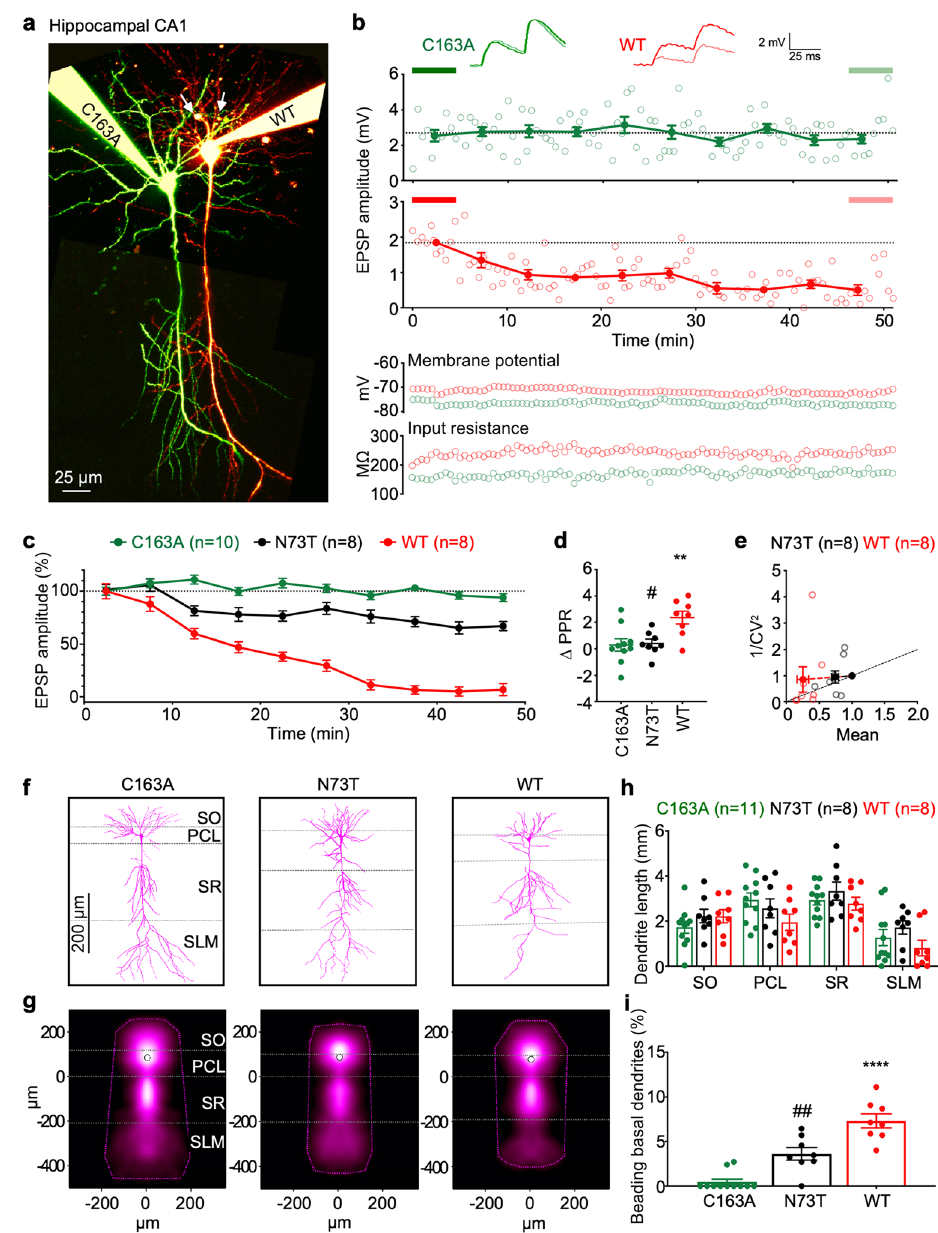
Figure 7. Casp6N73T is less damaging to neuronal function and neurodegeneration than Casp6WT. ( a ) Representative two-photon images of 10 pg Casp6C163A- (Alexa 488, green) and 10 pg Casp6WT- or Casp6N73T- (Alexa 594, red) patched hippocampal CA1 pyramidal neurons. White arrows indicate basal dendrite degeneration. Scale bar: 25 µm. Maximum-intensity projection of two-photon stacks was compiled using ImageJ, and imaging montage of entire neurons was performed using Affinity Designer 1.7. ( b ) Sample EPSP time course plots from Casp6C163A- (green) and Casp6WT- (red) patched neurons in ( a ), showing reduction of neurotransmission for Casp6WT (1.53 ± 0.32 mV, n = 8 vs. 0.14 ± 0.07 mV, n = 8, p < 0.01) but not for Casp6C163A (1.94 ± 0.32 mV, n = 10 vs. 1.91 ± 0.29 mV, n = 10, p = 0.76) when comparing the last 10 traces (light thick line) to the first 10 traces (dark thick line). Open circles: EPSP amplitude recorded every 30 s. Closed circles: EPSP amplitude binned and averaged across 10 traces. Inset: representative EPSP traces highlight the paired-pulse ratio (PPR). Scale bars: 2 mV, 25 ms. Resting membrane potential and input resistance remained stable throughout experiment. ( c ) EPSP time courses for Casp6C163A- (n = 10), Casp6N73T- (n = 8), or Casp6WT- (n = 8) patched neurons. ( d ) PPR from Casp6WT-, Casp6C163A- or Casp6N73T- patched neurons. One-way ANOVA (p = 0.0043), followed by Tukey’s post-hoc test (**p < 0.01 vs. C163A; #p < 0.05 vs. WT). ( e ) CV analysis of Casp6N73T- and Casp6WT-patched neurons. Casp6C163A was unaltered. ( f ) Representative reconstructions of Casp6C163A-, Casp6N73T-, or Casp6WT-patched neurons. Image stacks were used for manual reconstruction of 3D morphologies using the Neuromantic freeware (http:// www. readi ng. ac. uk/ neuro mantic/ body_ index. php). ( g ) Dendritic density maps of Casp6C163A- (n = 11), Casp6N73T- (n = 8), or Casp6WT- (n = 8) patched neurons generated using custom software running in Igor Pro 8 v8.04 (https:// www. wavem etrics. com, https:// github. com/ pj- sjost rom/ qMorph). Dotted lines show the convex hull of the maximum extent. ( h ) Cumulative dendritic length of reconstructed neurons in layers SO, PCL, SR, and SLM. ( i ) Casp6C163A-, Casp6N73T- and Casp6WT-patched CA1 pyramidal neurons beading basal dendrites. One-way ANOVA (p = 0.0001), followed by Tukey’s test (****p < 0.0001 vs Casp6C163A, ##p < 0.01 vs